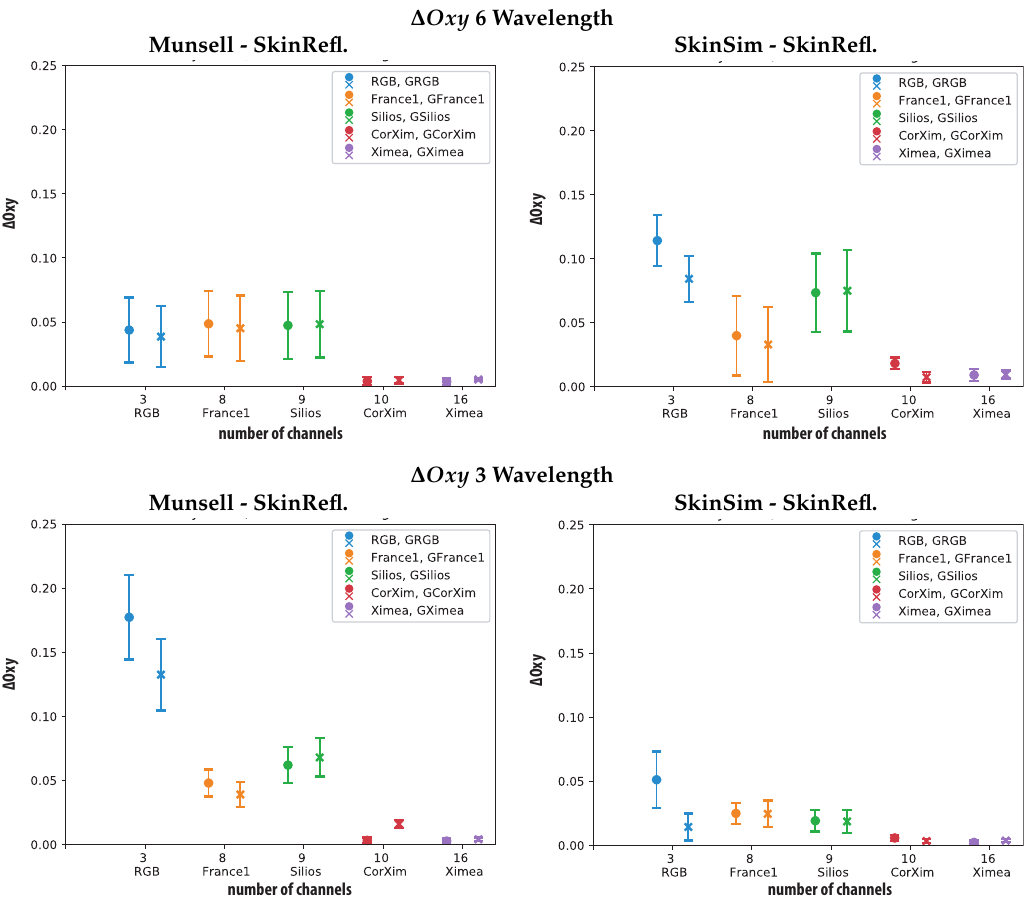
Figure 8. Resulting values for ∆ Oxy metric calculated using six wavelength (500 nm, 520 nm, 540 nm, 560 nm, 580 nm, 600 nm) ( top ) and three wavelengths (480 nm, 560 nm, 600 nm) ( bottom ) for all Sensors. Munsell set ( left ) as training and Skin Simulation set ( right ) including standard deviation of the